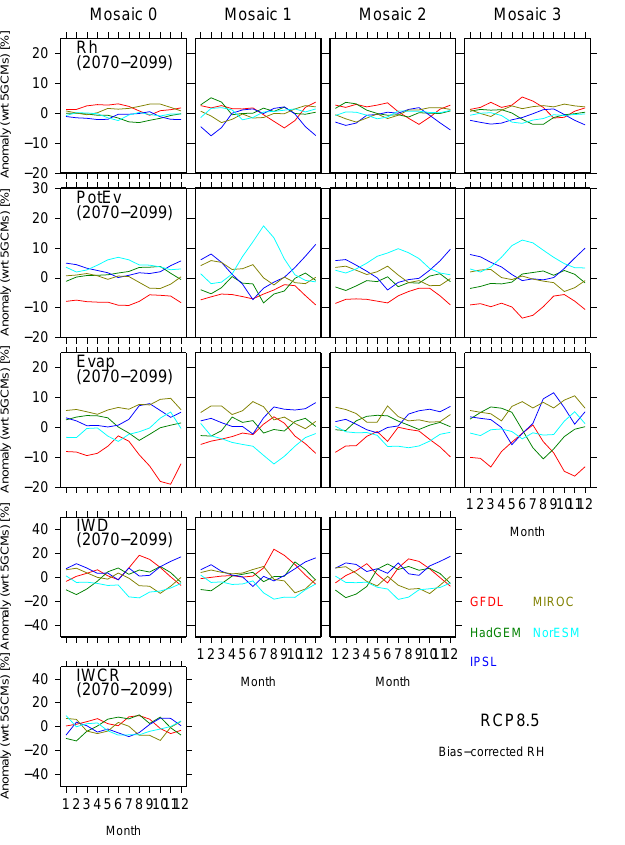
Figure 14. Monthly anomalies with respect to the ensemble mean in five GCMs with bias-corrected humidity data for 1971–2000. The results are aggregated over each land use. The anomaly in each GCM is indicated in different colors: (red) GFDL, (green) HadGEM, (blue) IPSL, (dark yellow) MIROC and (light blue) NorESM. The panels from top to bottom show the relative humid- ity, potential evapotranspiration, evapotranspiration, irrigation wa- ter demand (IWD) and irrigation water consumption from rivers (IWCR).